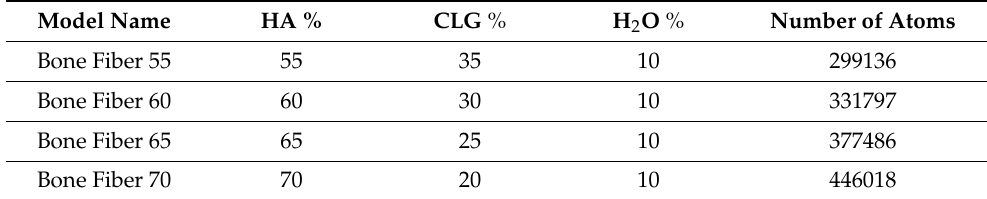
Table 1. Devised Bone Fiber models, the mass percentages of the bone constituents, and their total number of atoms.